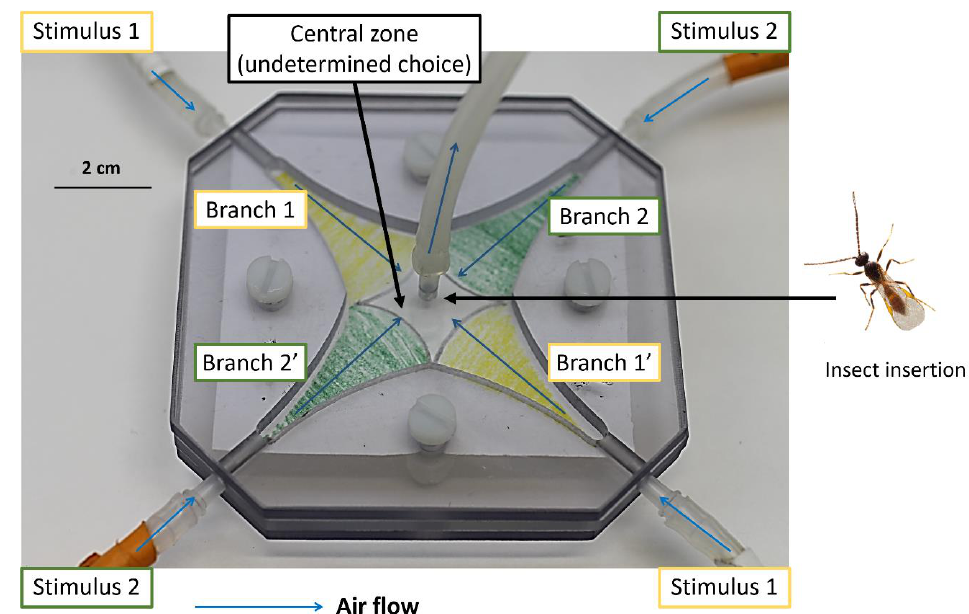
Figure 1. Four-way olfactometer setup used for the behavioral assays. A constant air flow allows diffusion of olfactory stimuli in each branch through polytetrafluoroethylene (PTFE) tubes connected to vessels with infested plants. The same colors, added for illustration only, indicate branches containing odors from the same host–plant complex (HPC). The diamond-shaped “central zone” in the center of the olfactometer is considered as zone of undetermined choice. After allowing the odors to diffuse in the device, parasitoids were inserted through a hole in the center of the olfactometer and observed during 600 s.